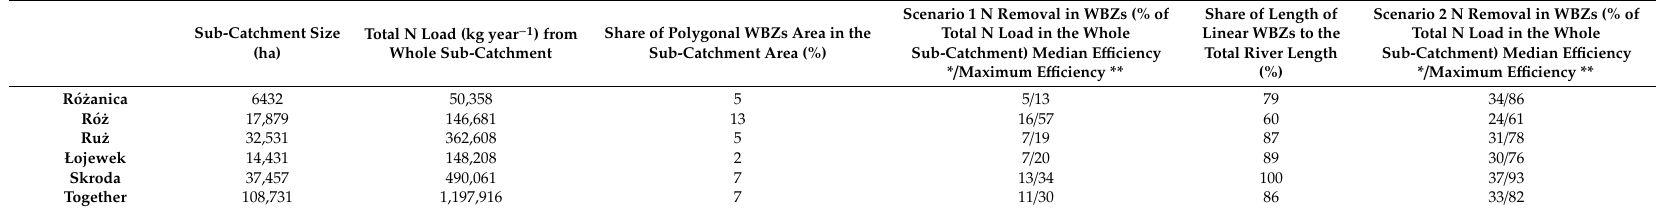
Table 2. Nitrogen load and